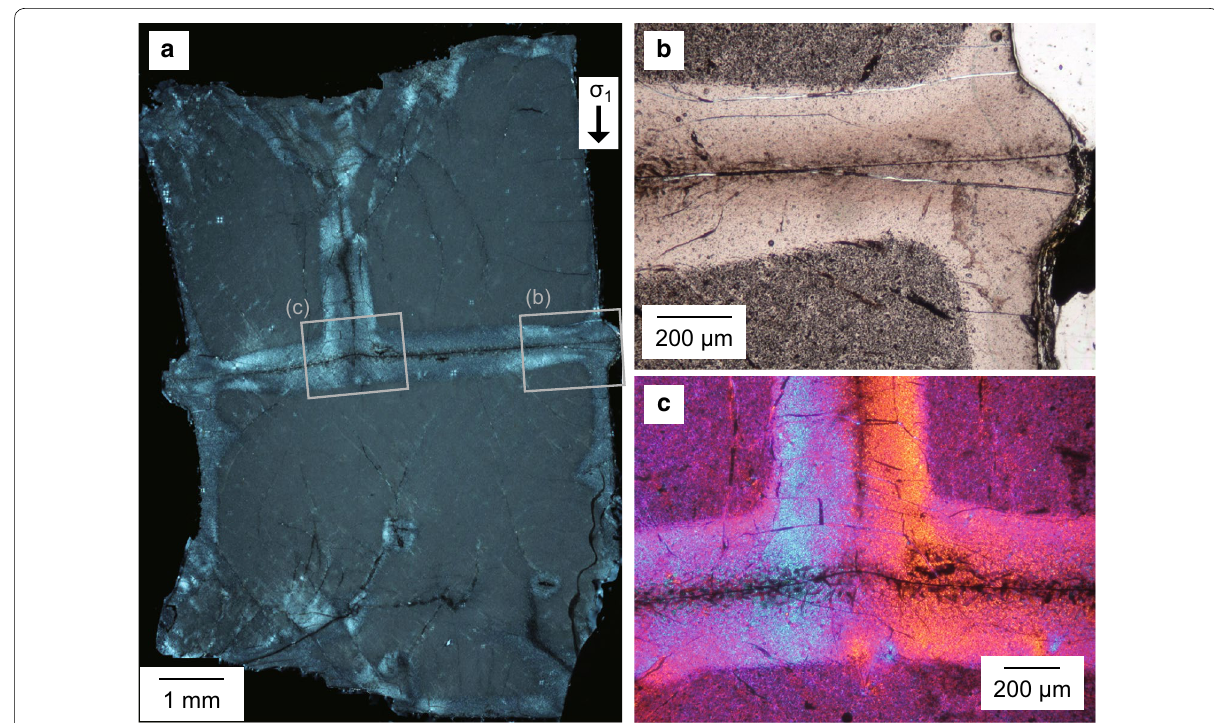
Fig. 5 Optical image of the deformed water‑added sample. a Image of the entire sample (cross‑polarized light). The compression direction ( σ 1 ) is shown by an arrow. Transparent parts can be seen at the upper and lower sample boundaries, the edge of the sample column, and around the frac‑ tures with a width of ca. 200 μm. Bulging can be recognized at the lateral sample boundaries. Rectangles denote the locations for enlarged images ( b ) and ( c ). b Bulging part (plane‑polarized light). c Sample boundary and upward fracture (cross‑polarized light with a gypsum plate). The sample boundary (a few tens of μm) is especially dusty, which is related to the formation of zoisite (Fig.